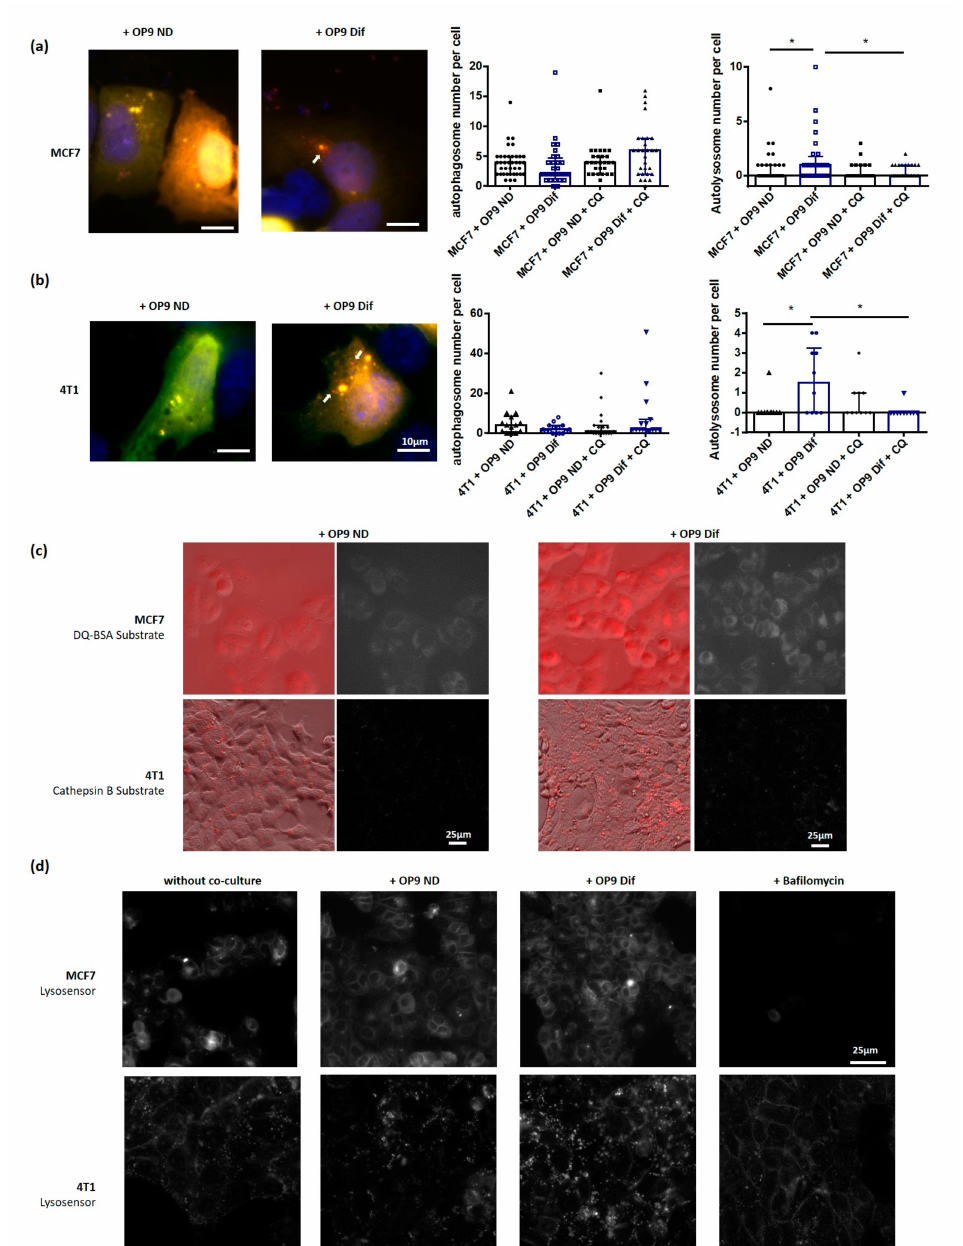
Figure 3. Adipocytes promote autolysosome maturation, intracellular degradation and lysosomal acidification in breast cancer cells. ( a , b ) Autophagosome and autolysosome number was measured using the LC3-GFP-mRFP plasmid in MCF7 ( a ) and 4T1 ( b ) cells in co-culture with OP9 ND and OP9 Dif for 48 h. DAPI was used to normalise by cell number. White arrows show red autolysosomes: due to acidic pH, GFP signal is quenched in autolysosomes. In the case of autophagosomes, dots are yellow (GFP and RFP signals). (Median ± interquartile range, Kruskal–Wallis test followed by Dunn’s